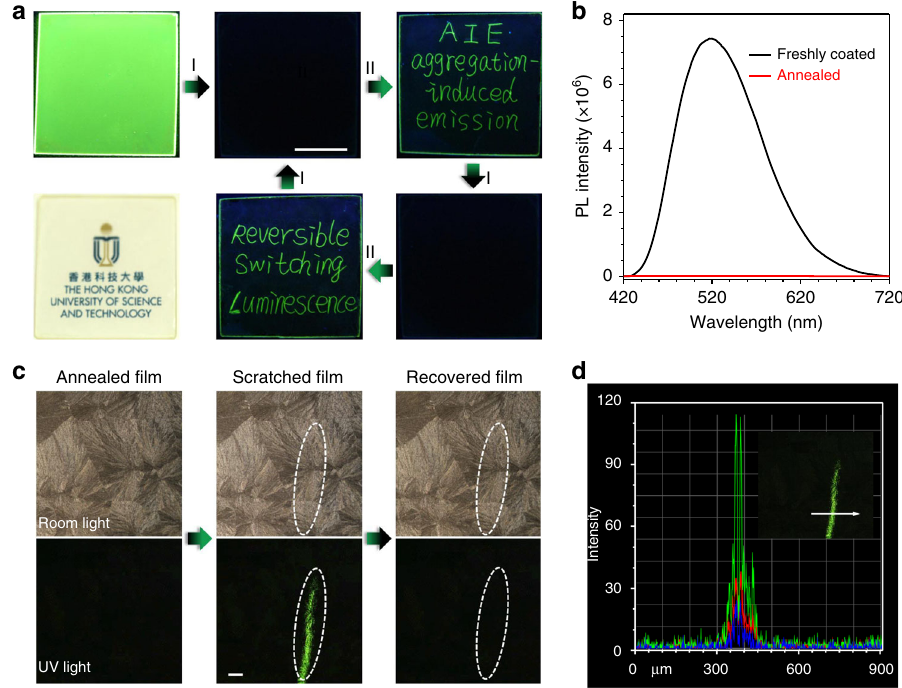
Fig. 4 High performance On – Off MRL properties of TPE-4N in thin- fi lm state. a Luminescent and room-light transparent photos of TPE-4N thin fi lm spin- coated on quartz plate and records of the writing and erasing processes, Process I: heated by a handed heat gun at 150 °C for 3 s; Process II: writing with a fi ne glass tube. Scale = 1 cm. b PL spectra of coated and annealed thin fi lm. c Polarizing optical microscopic images of annealed, slightly scratched and recovered fi lm under room light and UV light. Scale = 100 µ m. d PL intensity contrast spectrum for the slightly ground fi lm in c . All the luminescent photos